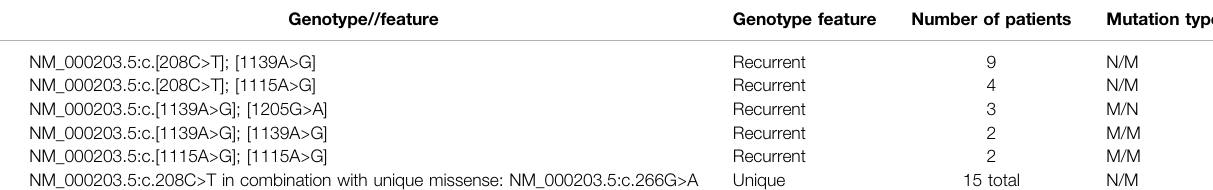
TABLE 5 | Patients with MPS I with an attenuated phenotype. ( n (cid:1)